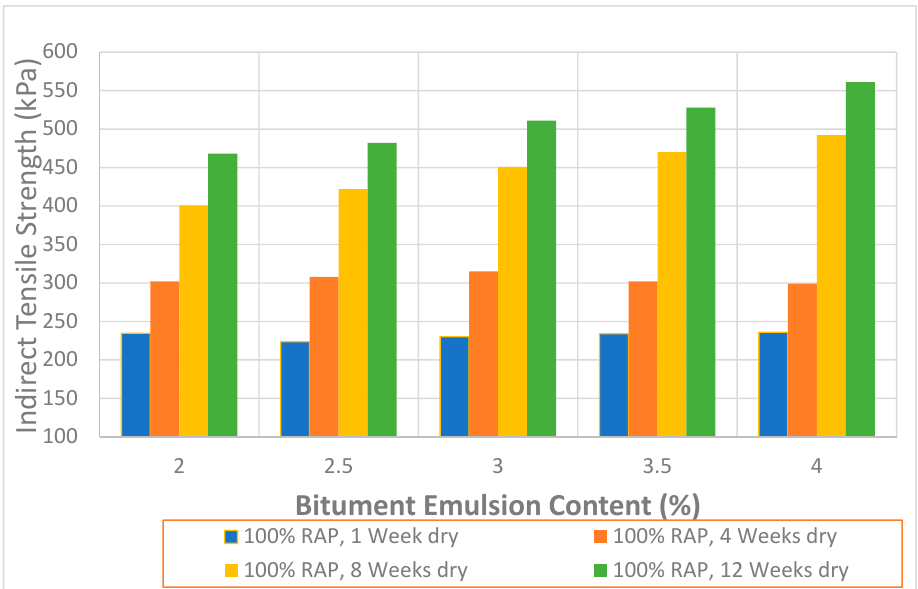
Figure 7. Results for the indirect tensile strength test after 4, 8, and 12 weeks of curing.